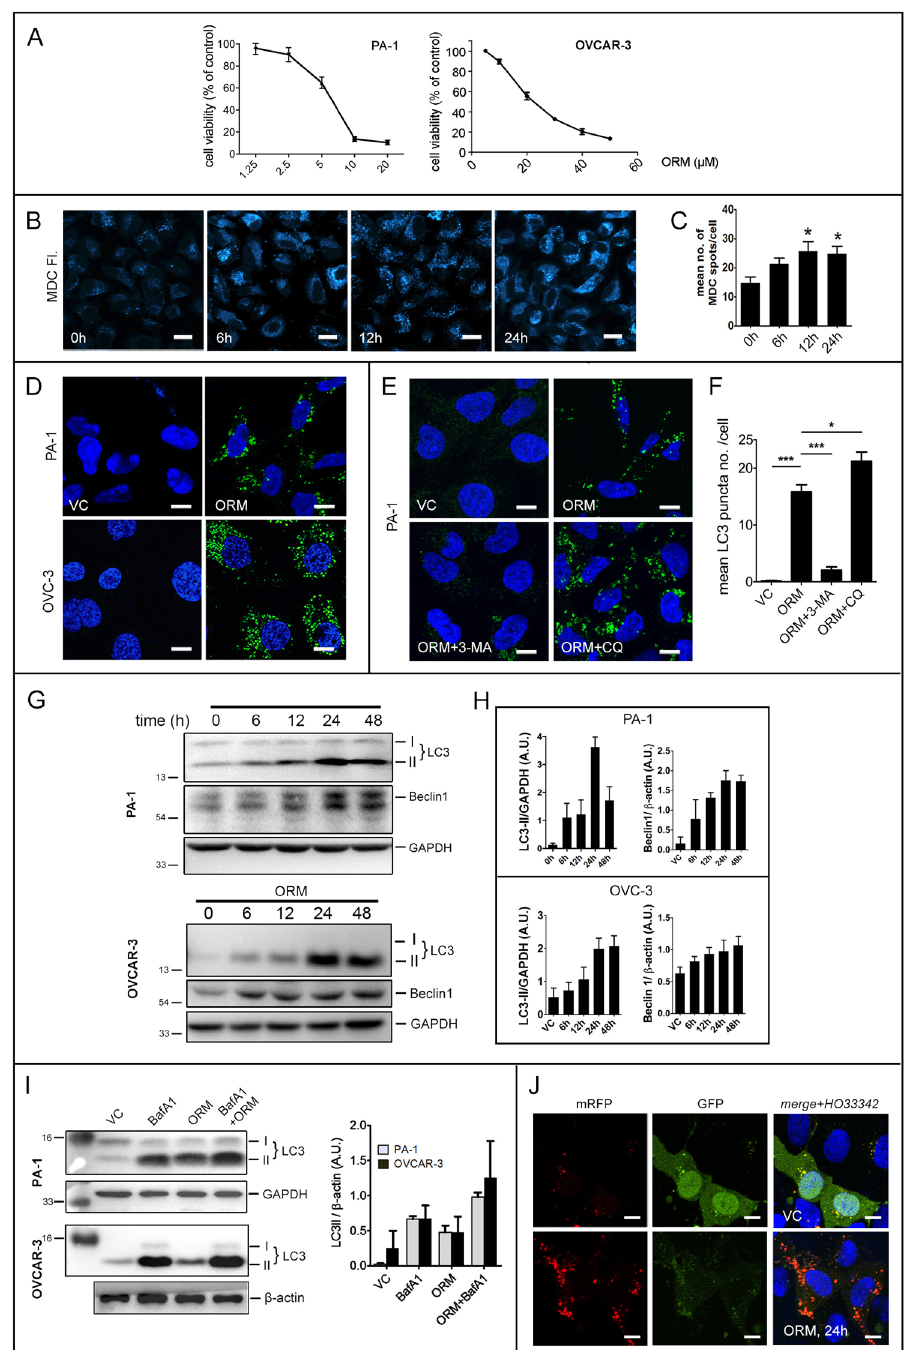
Figure 1. ORM induces autophagic flux in ovarian cancer cells PA-1 and OVCAR-3. ( A ) Dose-response curve of ORM in ovarian cancer cell lines PA-1 and OVCAR-3. ( B ) PA-1 cells were stained with MDC, a marker of acidic cellular compartments after treatment with indicated time periods with IC 50 dose of ORM. ( C ) quantification of MDC-positive dots from ( B ) as described in Methods. ( D ) Confocal microscopy images of PA-1 and OVCAR-3 cells treated with IC 50 dose of ORM and immunostained with LC3 (an autophagosome marker). ( E ) PA-1 cells were pre-treated with or without 3-MA (class III PI3K inhibitor; 2.5 mM) or CQ (lysosomal fusion inhibitor; 10 μ M), immunostained with LC3 and imaged in confocal microscope. ( F ) Quantification of LC3 puncta from data such as ( E ) as described in Methods. ( G ) PA-1 and OVCAR-3 cells were treated with ORM (IC 50 dose) for indicated time-points and probed for autophagy markers LC3 and Beclin 1, quantified in ( H ). ( I ) PA-1 and OVCAR-3 cells were pre-treated or not with lysosomal fusion inhibitor BafA1 (100 nM; 2 h) to inhibit fusion of autophagosomes with lysosomes. LC3-II conversion was observed with immunoblotting and quantified. ( J ) PA-1 cells were transfected with tfLC3 (as described in Methods), treated with ORM for 24 h and imaged in confocal microscope. Scale bars = 20 μ m ( B ); 10 μ m ( D